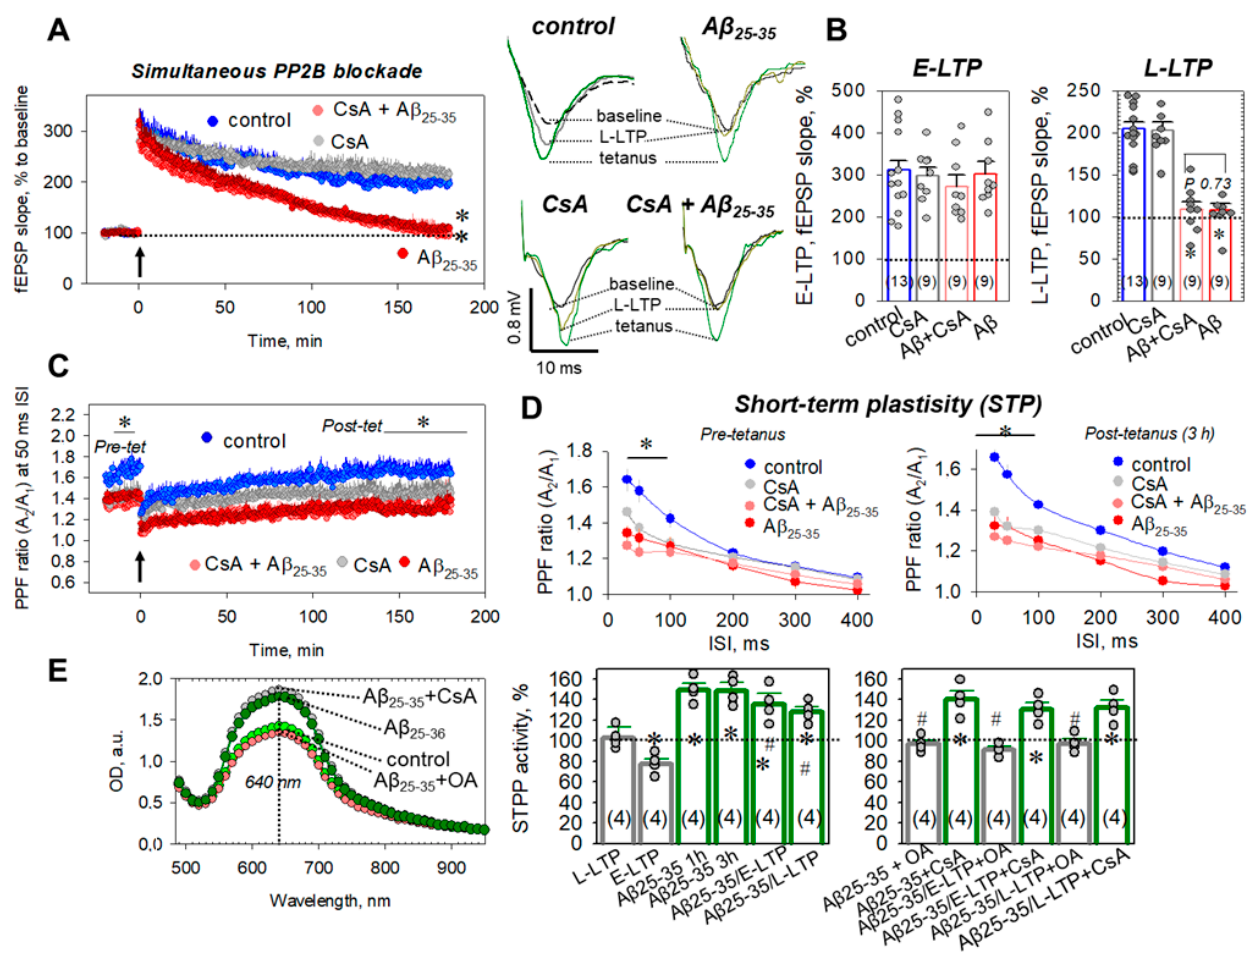
Figure 2. The PP2B blockade during the A β 25-35 -dependent impairment of hippocampal synaptic plasticity. ( A ) Averaged curves for control slices (blue circles, n = 13), cyclosporin A (CsA)-treated slices (5 μ M, gray circles, n = 9), A β 25-35 -treated slices (dark red circles, n = 9), and CsA+ A β 25-35 -treated slices (red circles, n = 9). Arrow at 0 min indicates start of tetanic stimulation; dotted line 100% represents normalized fEPSPs corresponding to the pre-tetanic level. Right panels display typical fEPSP responses of studied groups for pre-tetanic levels (baseline), at the start of post-tetanic recordings (tetanus) and 180 min after LTP induction (L-LTP). ( B ) Summarized statistics for ( A ) curves during early phase (E-LTP, 0–3 min) and late phase (L-LTP, 178–180 min) of long-term potentiation. * denotes p ˂ 0.05 for comparing the group with control; # indicates p ˂ 0.05 for comparison of groups between themselves. ( C ) Paired-pulse facilitation (PPF) curves at the 50 ms ISI corresponding to the ( A ) recordings. ( D ) PPF ratios for different interstimulus intervals (30–400 ms) before tetanic stimulation (left panel, pre-tetanus) and for L-LTP, 3 h after tetanus (right panel, post-tetanus). ( E ) Optical density spectra for control (green circles) and A β 25-35 -treated samples (dark green circles), as well A β 25-35 + OA (red circles) and A β 25-35 + CsA-treated (gray circles) samples, normalized to the total protein levels. Right panels indicate summarized statistics for serine/threonine phosphatase activity (STPP) in tested groups. * denotes p ˂ 0.05 for comparing the group with control; # indicates p ˂ 0.05 for comparison of groups between themselves. The number of independent experiments corresponding to different animals is indicated in parentheses.